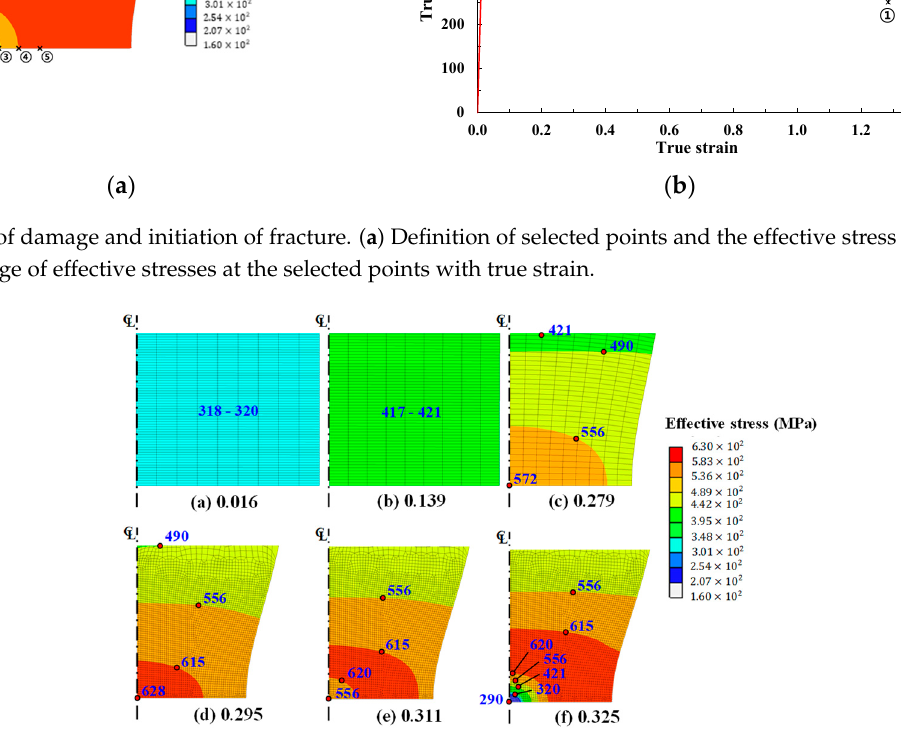
Figure 11. Tensile behavior predictions based on the softening and fracture points S and F, respec- tively, for the present model with different damage models [52–55]. 4. Discussions and Conclusions 4.1. Discussions Accuracy of finite element predictions of metal forming processes depends domi- nantly on flow behaviors together with tribological factors. Even though discrete or piece- wise description methods of the flow behaviors are quite practical and flexible especially